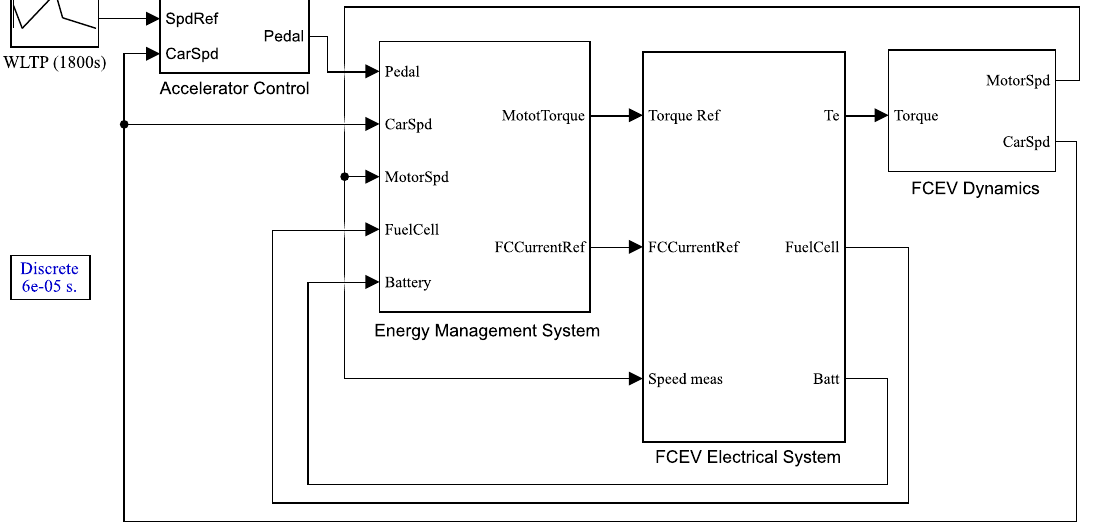
Figure 7. FCEV simulation platform with proposed